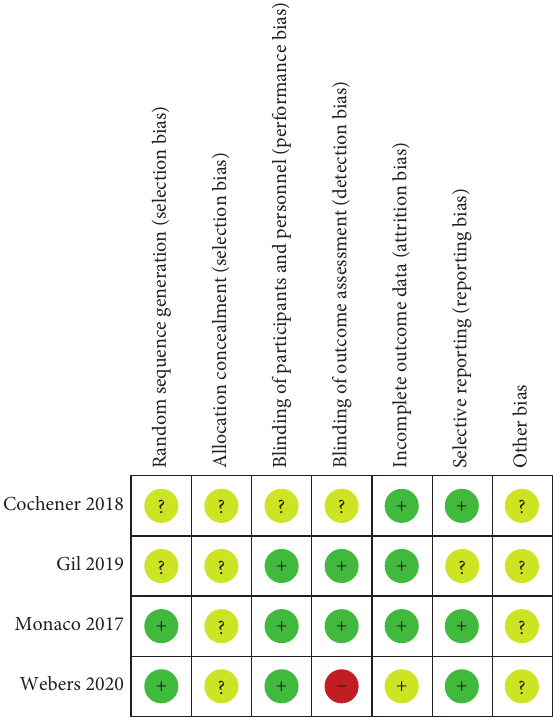
Figure 3: Summary of the risk of bias in the included randomized controlled